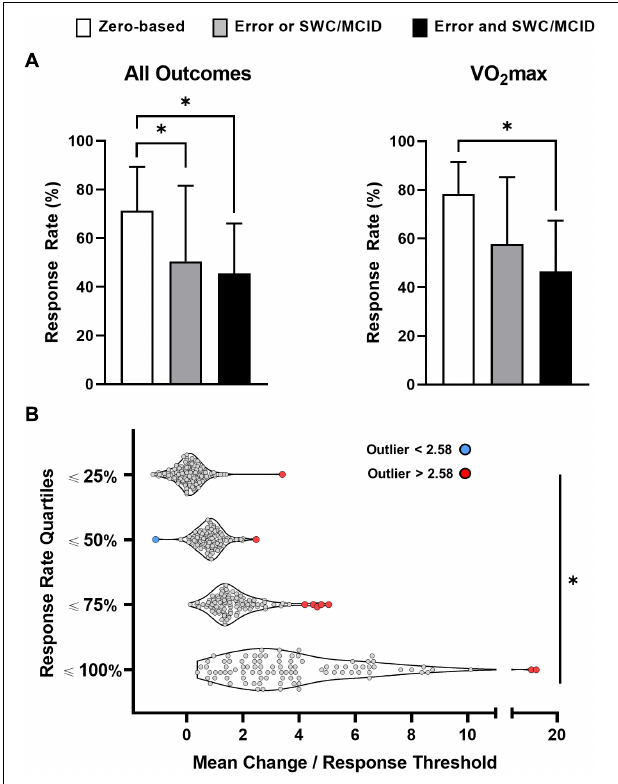
FIGURE 4 | Impact of classification approach [ A ; n = 614 (all outcomes); n = 75 (maximal oxygen uptake, VO 2 max)] and mean change (B) on response rates. Table 2 outlines the classification categories outlined in (A) . *Significant at p <